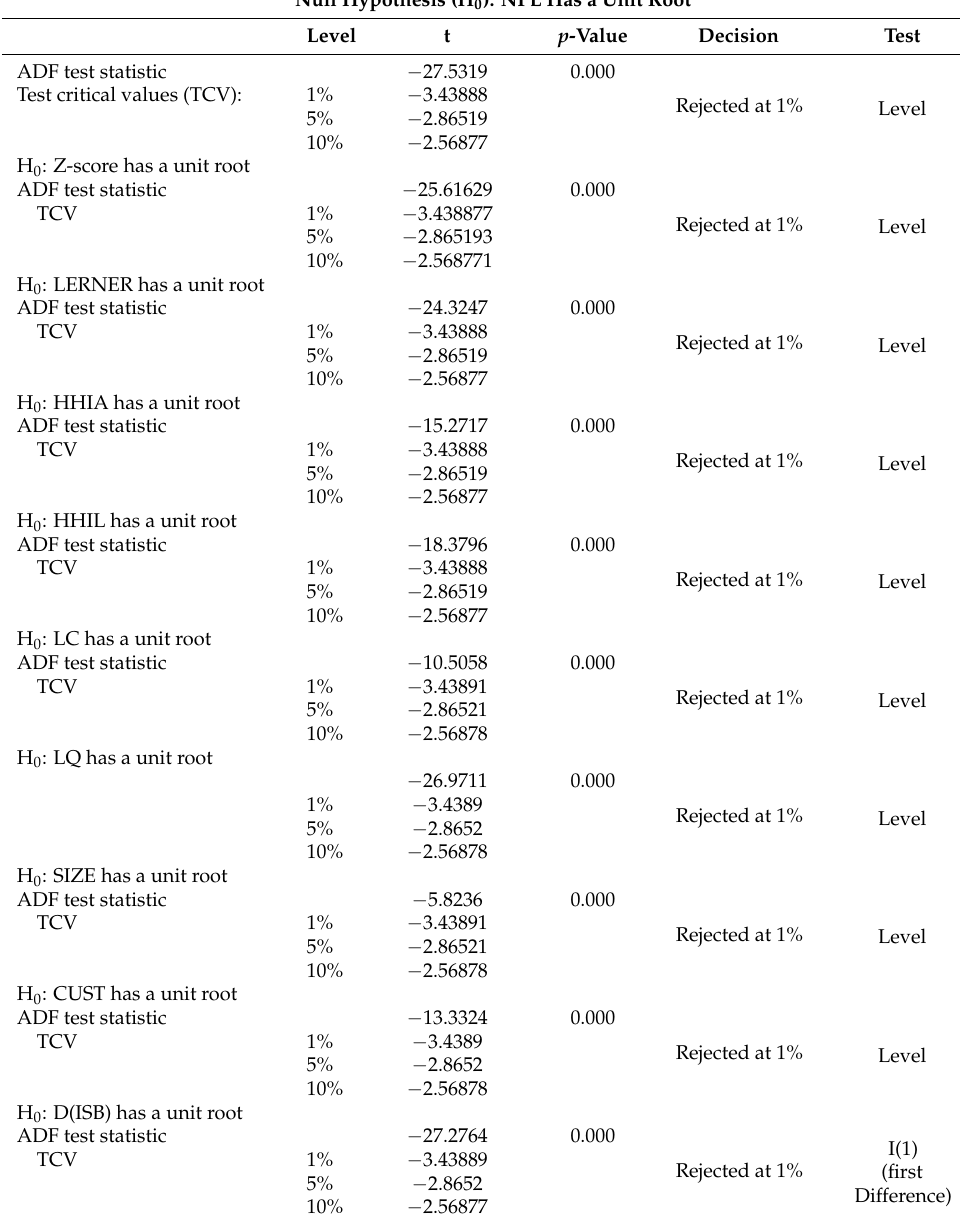
Table 1. ADF unit root